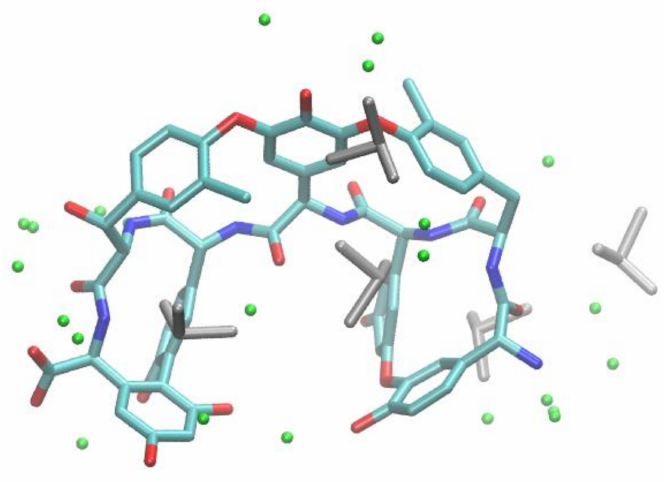
Figure 6. X-ray crystal structure of teicoplanin aglycone (TAG) (oxygen, red; nitrogen, blue; carbon, cyan) with DMSO (grey) and water molecules (green